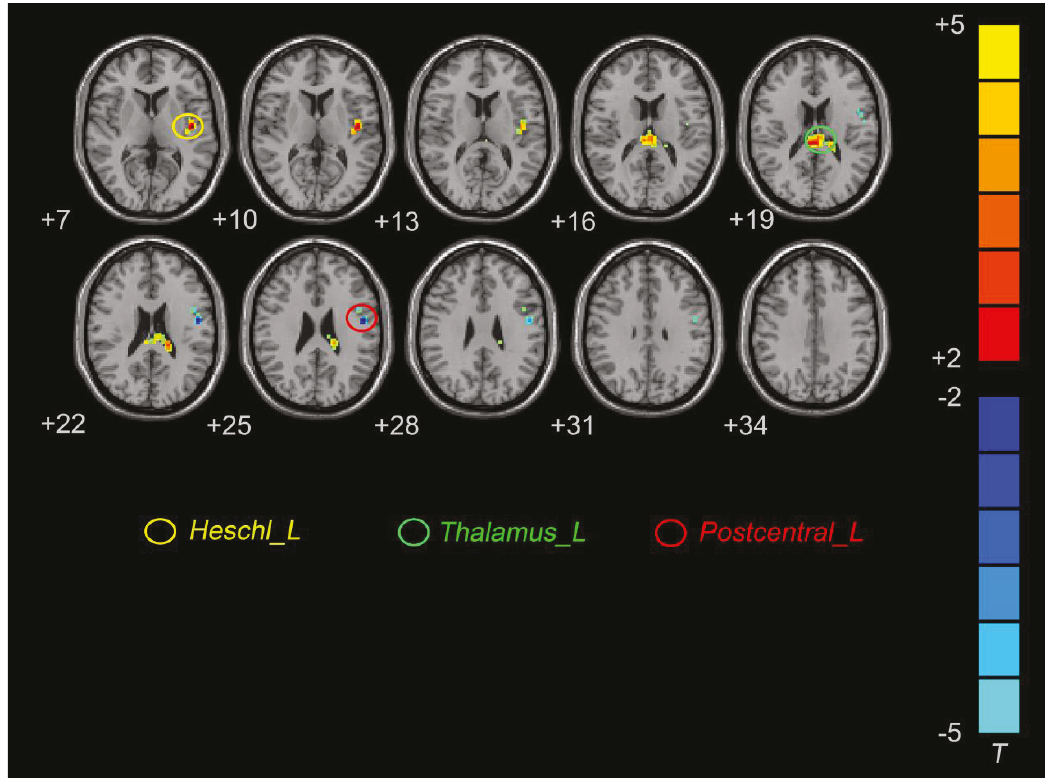
Figure 1: Brain regions showing di ff erent CReHo values between the D-MCI and nD-MCI groups in the typical frequency band ( contrast = D -MCI − nD-MCI). Table 2: Brain regions with signi fi cantly di ff erent CReHo values in the D-MCI group compared with the nD-MCI